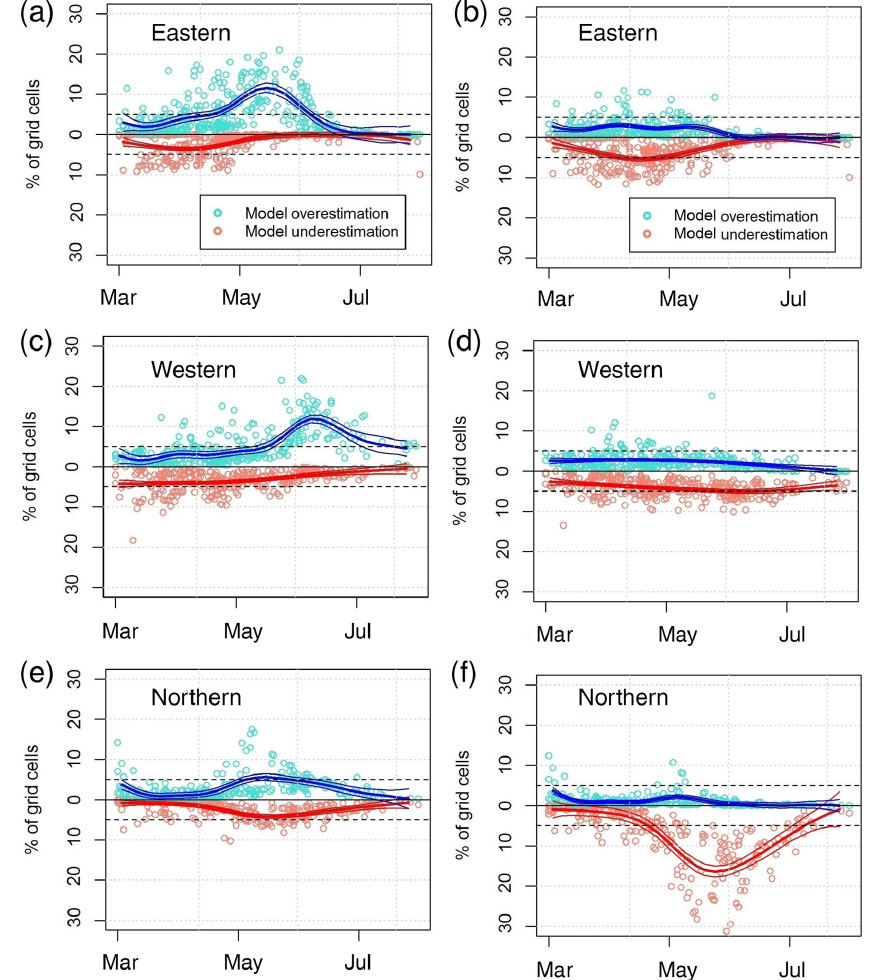
Figure 6. The model underestimation ( F u , red circles) and overestimation ( F o , blue circles) areas of SCA (% of all grid cells) in the three regions (Fig. 7) and for the two grid data versions (v.1.1 in the left column and v.2 in the right column) in 2001–2015 (on the days when a MODIS satellite image is available for comparison). The solid lines denote GAM curves (with standard error) fitted to the cloud of points. The horizontal dashed lines denote the 5% deviation level within which the model results are considered “good” in NVE operational snow mapping (Saloranta,